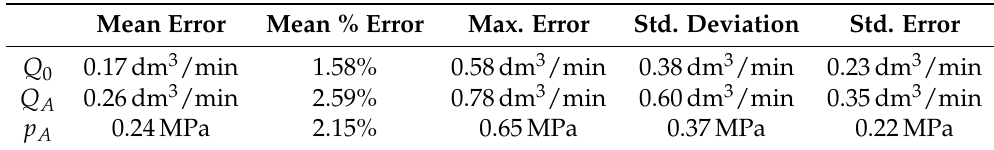
Table 6. Flow rate and pressure measurement